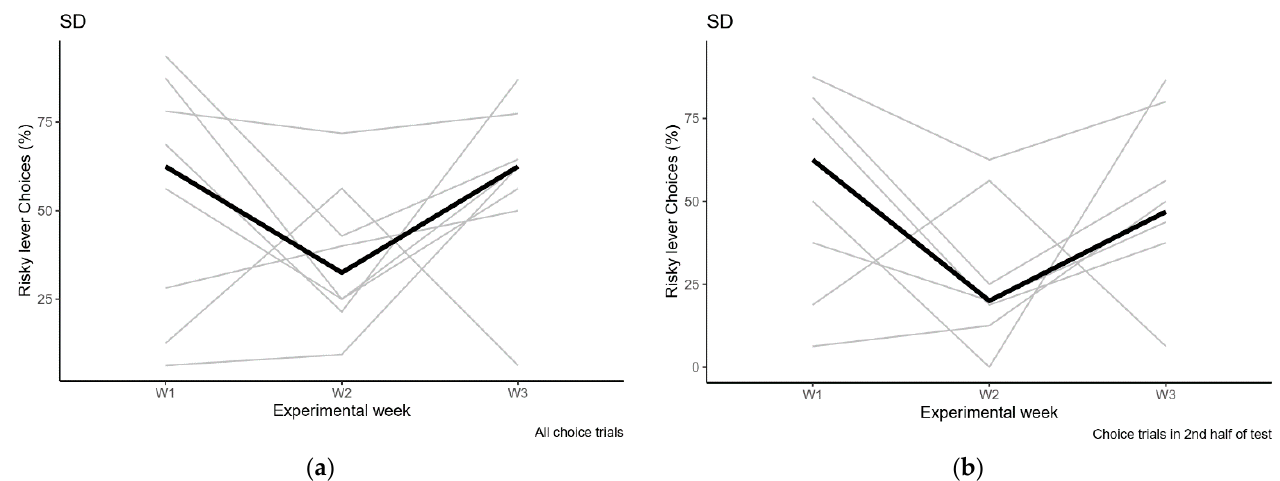
Figure 5. Risk preference in the sleep deprivation condition. ( a ) Preference in the completed choice trials from the entire session; ( b ) Preference in the completed choice trials from the second half of the session. Individual data in grey, median values in black. W1: baseline, W2: sleep deprivation, W3: recovery. Please note that rat 6 is excluded from Figure 5b because there were no data in the sleep deprivation condition. In this experiment, there is no significant effect of sleep deprivation on risk preference compared to baseline or recovery (as detailed in the text).